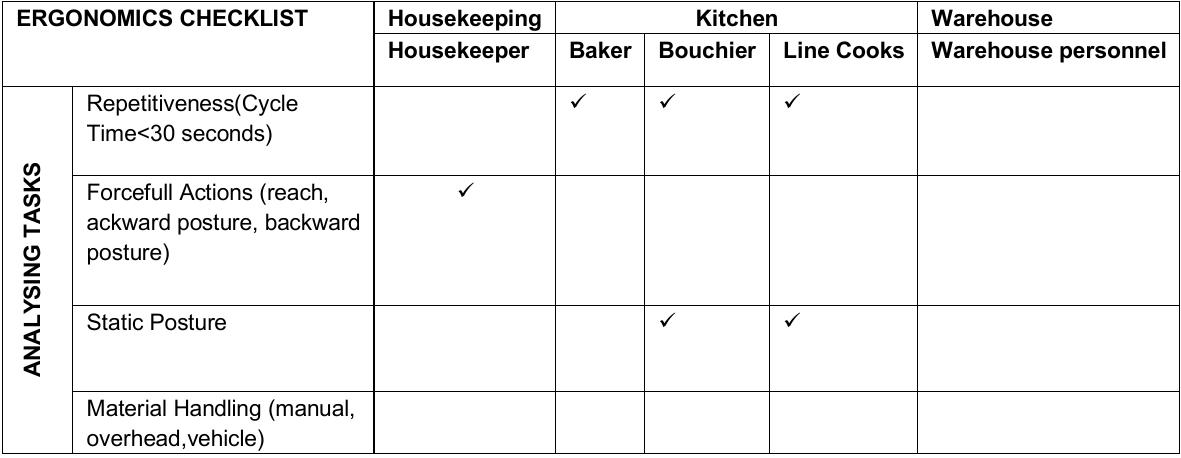
Table 2: Analysing